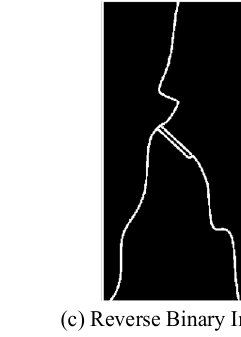
Figure 8. Digital image process of fracture plans.